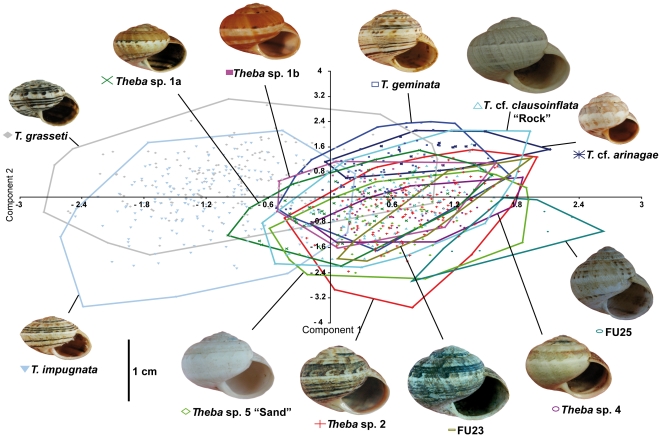
Principal component scatterplot (component 1 versus 2).The analysis was based on geometric morphometrics of ten shell parameters. Convex hulls circumscribe the areas occupied by each MOTU.